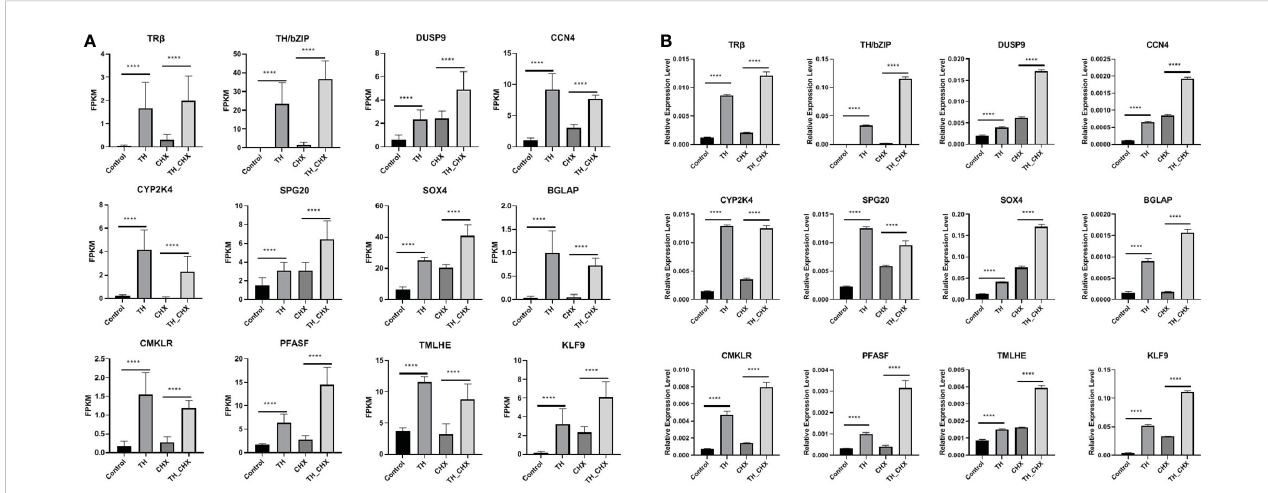
FIGURE 6 Expression patterns of selected genes in four groups (control, CHX, TH, and TH_CHX) determined by RNA-seq (A) and qPCR (B) . (A) In RNA-seq data, the vertical axis represents expression levels (FPKM value), and the horizontal axis represents four groups. The expression level for each sample is the means±SD of four replicates. (B) For qPCR, the data are means±SD from three independent replicates, and **** indicate highly signi fi cant differences between samples at p <0.0001 based on ANOVA. CHX, cycloheximide; TH, thyroid